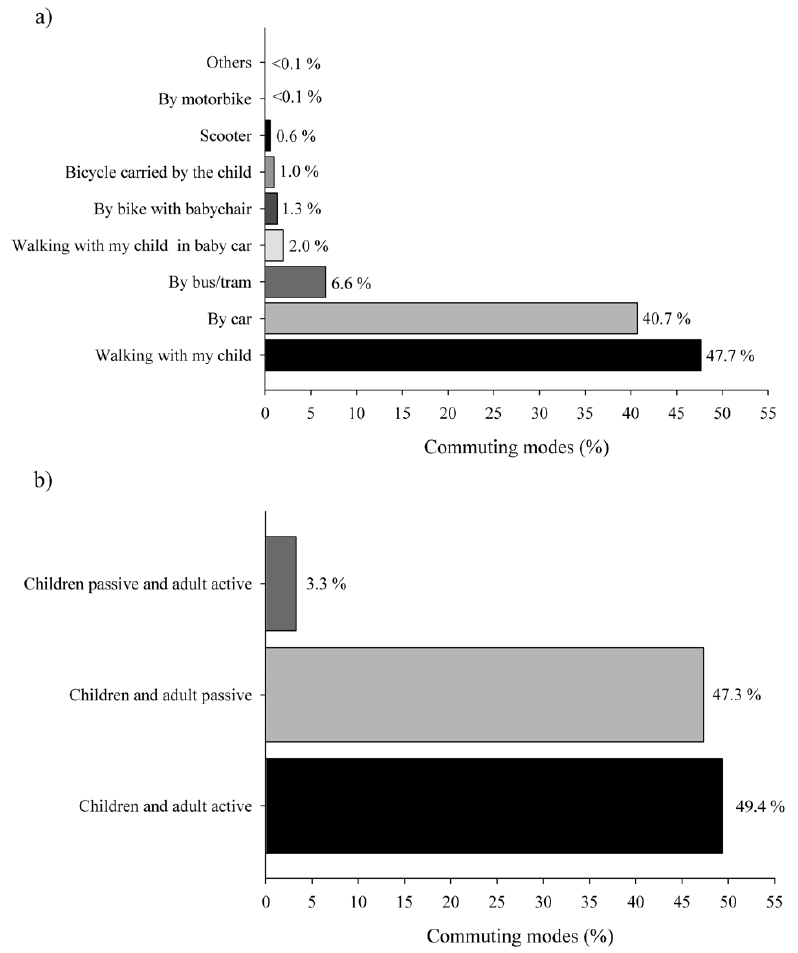
Figure 2. Prevalence (%) of the mode of commuting to school by response option (plot a) and by active and passive commuting (plot b). n = 2636 participants. active and passive commuting (plot b ). n = 2636